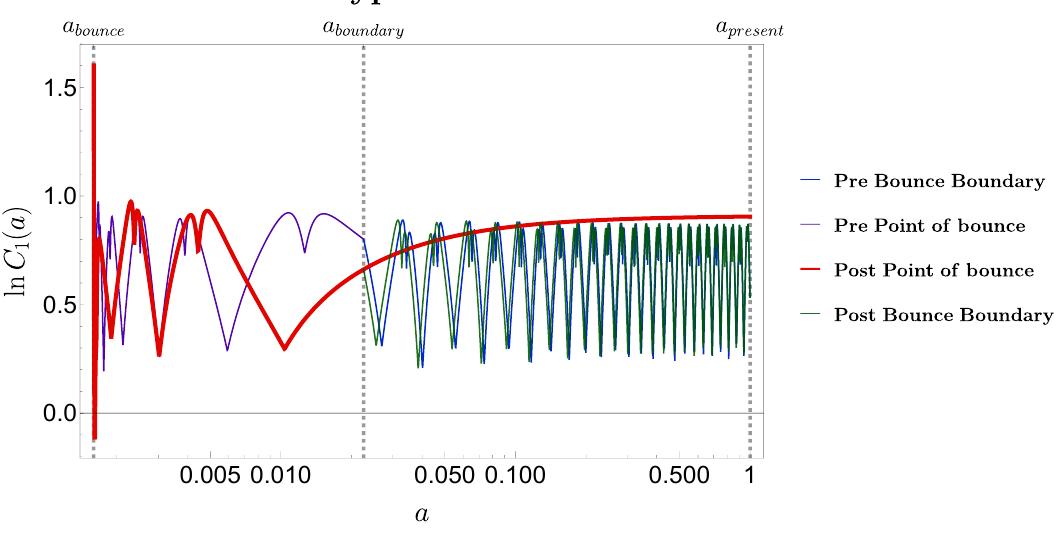
Figure 14: Logarithm of Linearly weighted Complexity value at different regions plotted against scale factor. Table 1: Complexity values at different points of interest with respect to scale